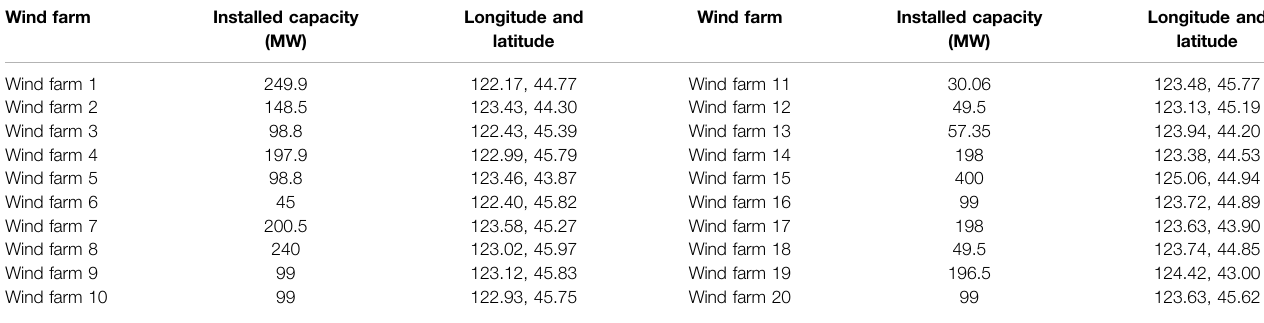
TABLE 3 | The installed capacity of wind farms in the case